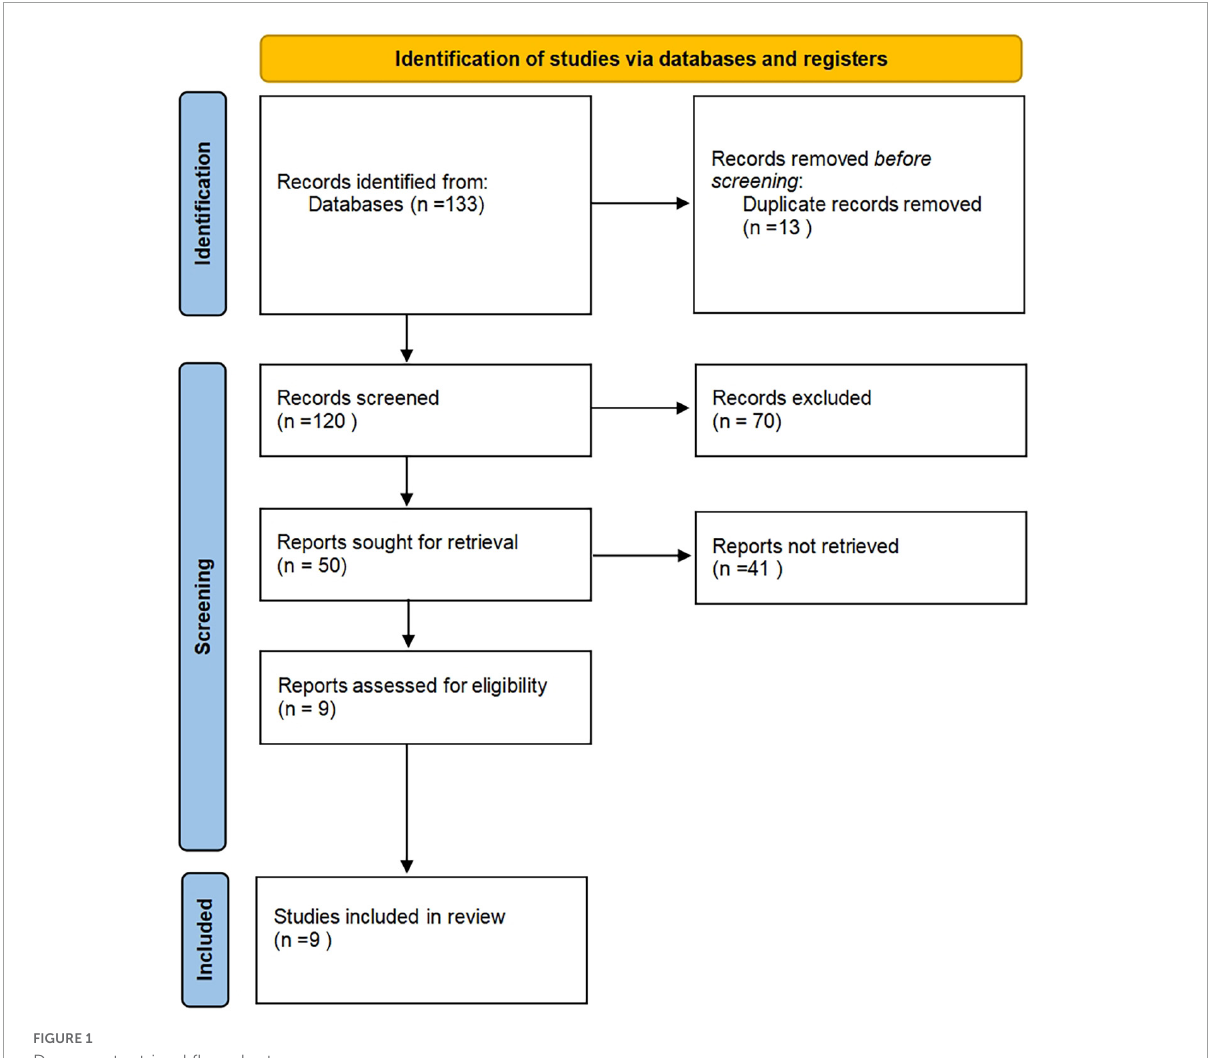
FIGURE1 Document retrieval flow